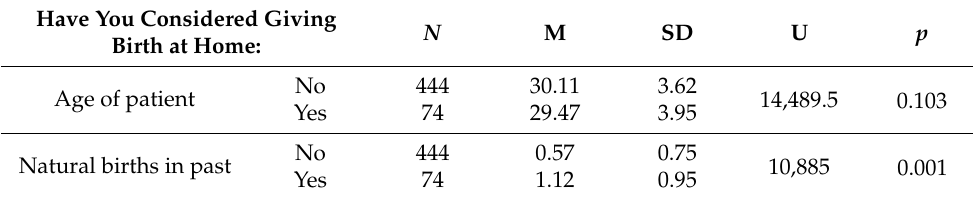
Table 5. The results of the analysis of the relationship between age and number of delivered vaginal births combined with the consideration of having a home birth.